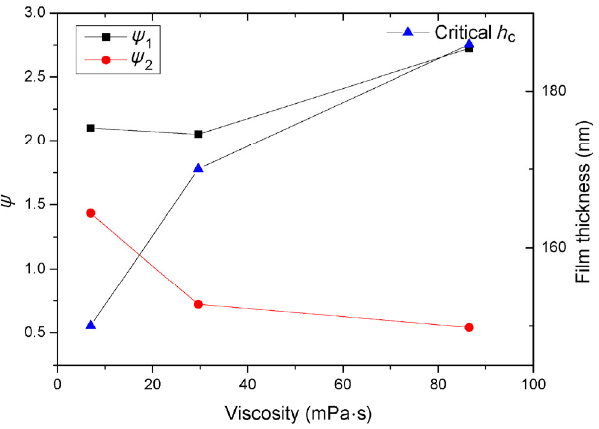
Fig. 2 Change of critical film thickness and the paramter ψ against viscosity for starved lubrication, pure rolling, p H = 431 MPa, t 0 = 25 ° C, oil supply: 0.85